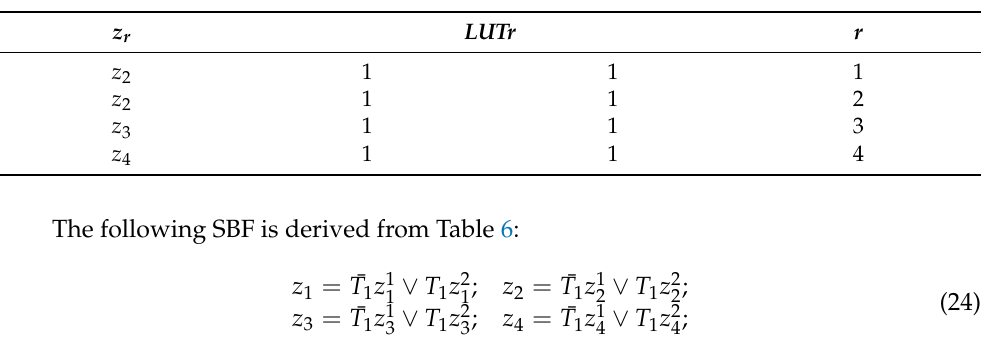
Table 6. Table of LUTerZV